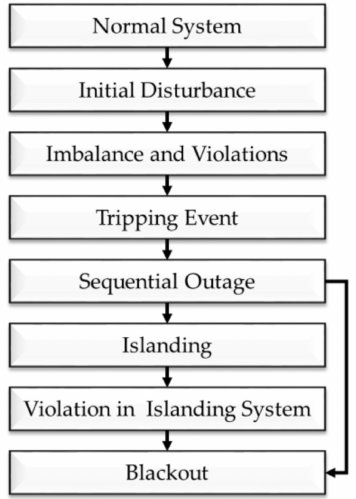
Figure 1. Sequential process of a large